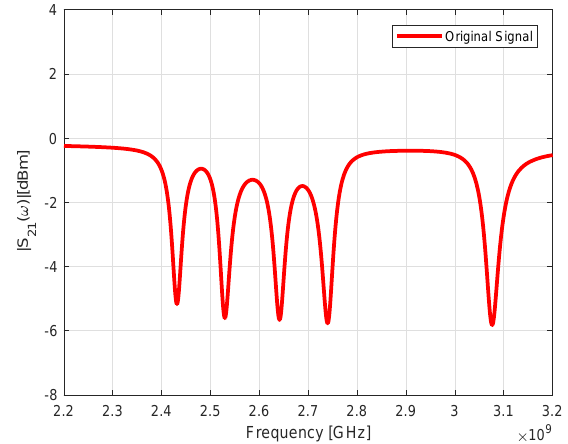
Figure 3. Received 5-bit signal for the tag configuration of